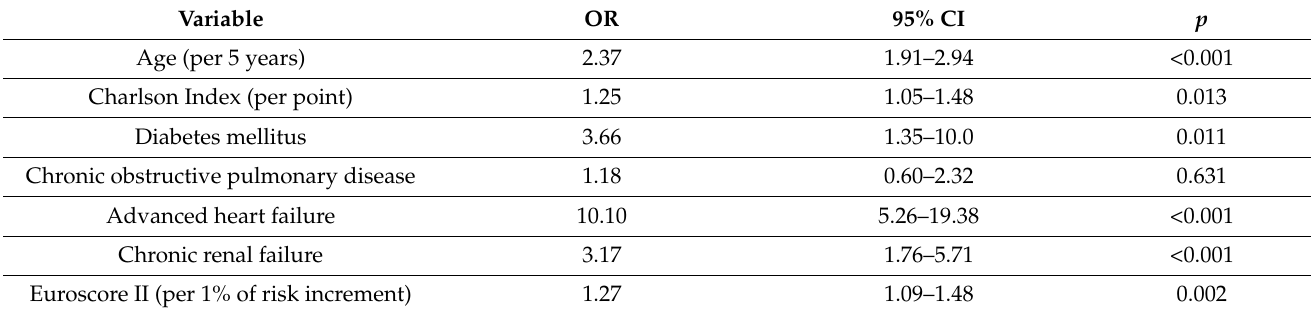
Table 2. Multivariate logistic regression model for creating the propensity score of TAVI vs. SAVR